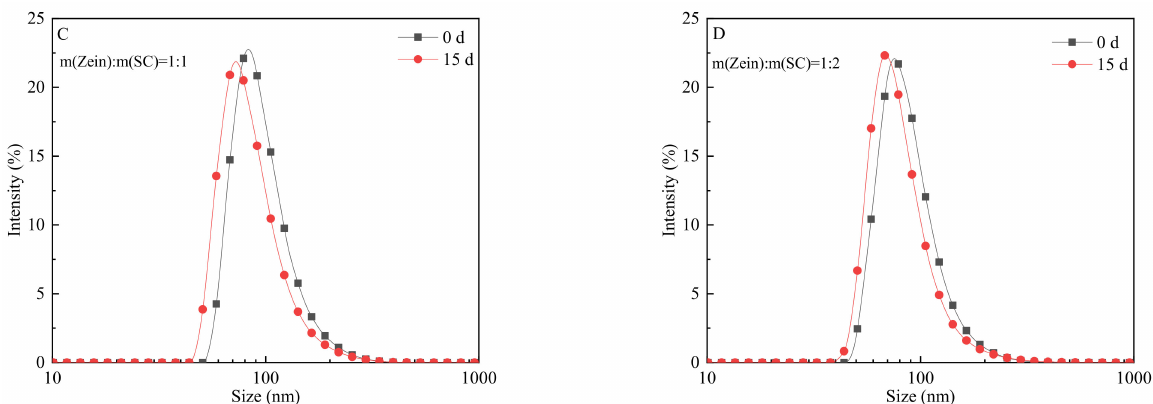
Figure 6. Size distributions of CA-loaded nanoparticles dispersed in water before and after 15 days (different samples with zein/SC mass ratios of ( A ) 4:1, ( B ) 2:1, ( C ) 1:1, and ( D ) 1:2; black square line represents freshly prepared, red spot line represents standing after 15 storage days).